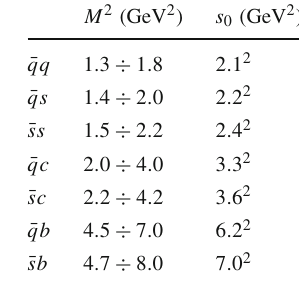
Table 2 The values of the magnetic dipole moments of the negative and positive parity tensor mesons in units of the nuclear magneton μ N Tensor